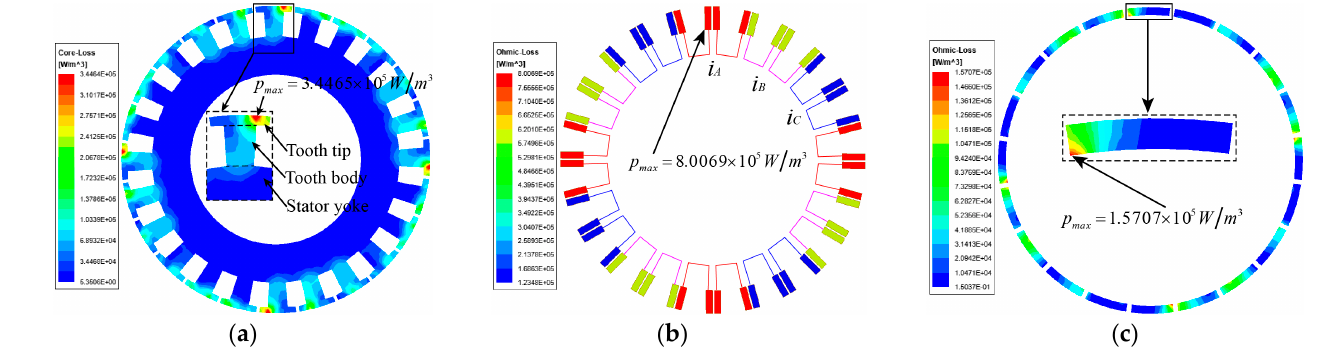
Figure 6. Iron loss distribution contour of PM motor during on-load condition: ( a ) Stator core loss; ( b ) Winding copper loss; ( c ) PM eddy current loss.